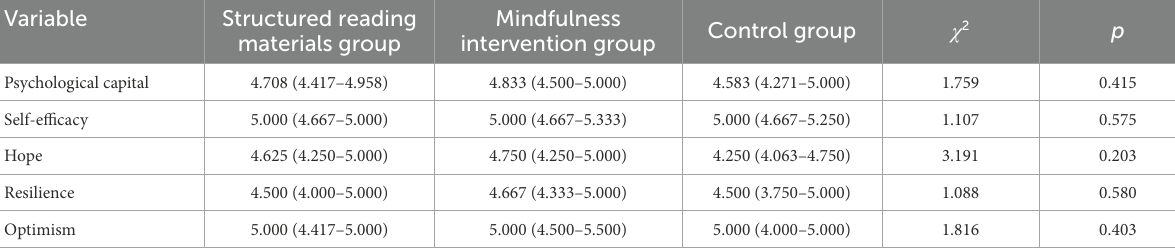
TABLE 2 Pre-test in experimental group and control group based on Kruskal–Wallis method.